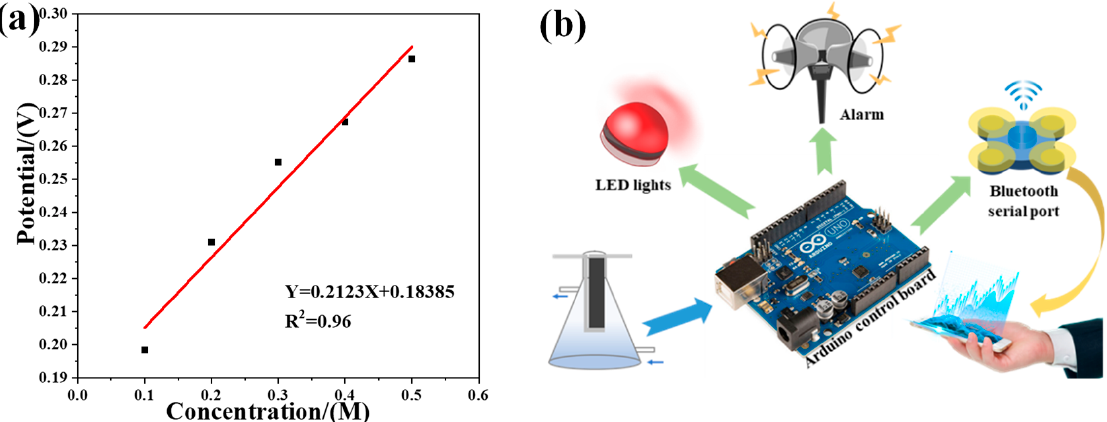
Figure 6. ( a ) The linear relationship between concentration and output voltage; ( b ) Schematic of the sensing system.